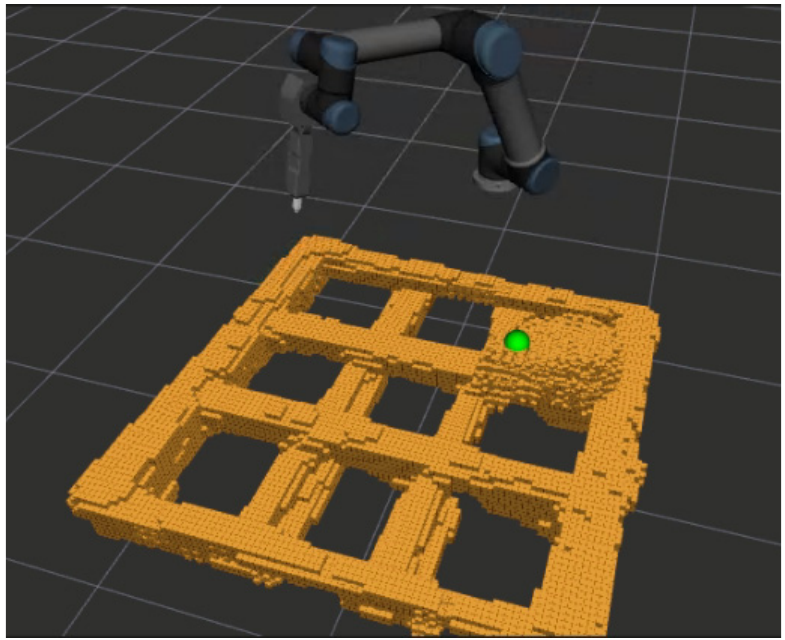
Figure 18. A pre-defined experimental test (Task 1): The arm tip is located out of the grill. The avoiding environment (the point cloud in boxes) consists of a single rock over the grill. The green circle corresponds to the target goal. circle corresponds to the target goal.